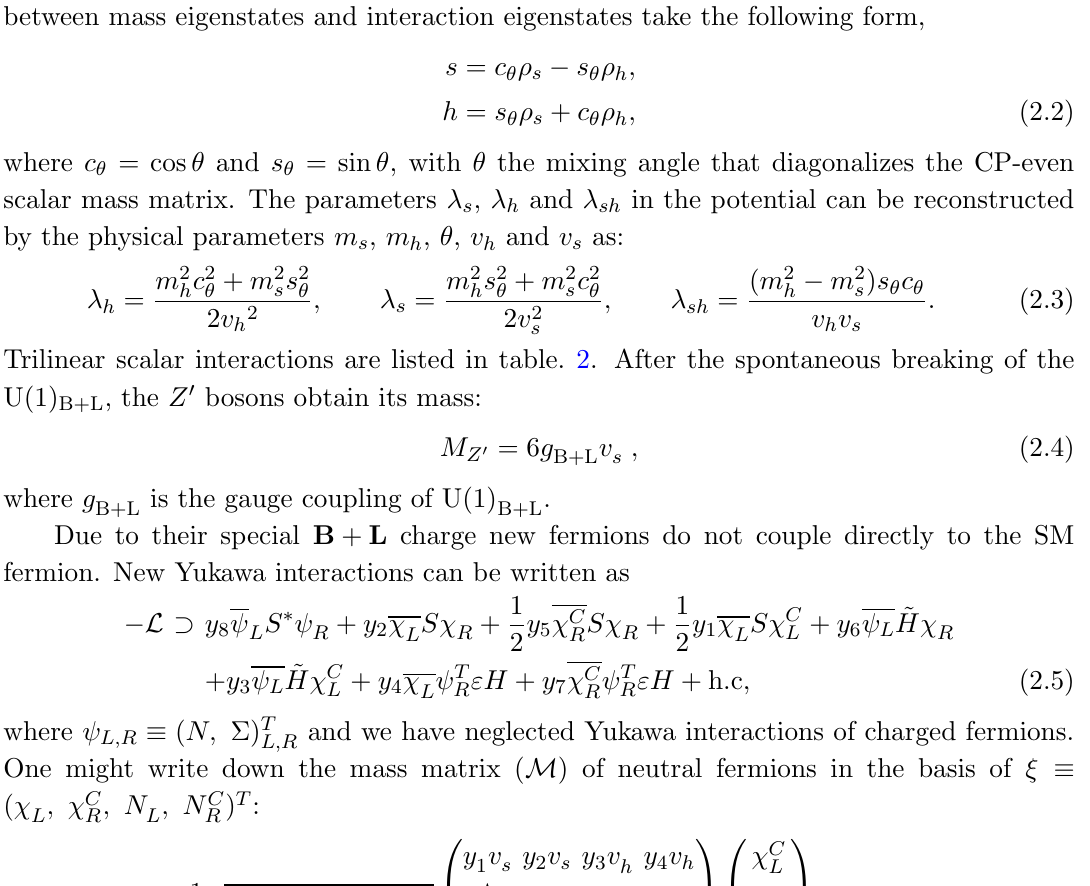
2 2 = (cid:21) v 2 + (cid:21) sh v and (cid:22) 2 = (cid:21) v 2 + (cid:21) sh v . Due to s h s h s s h h 2 2